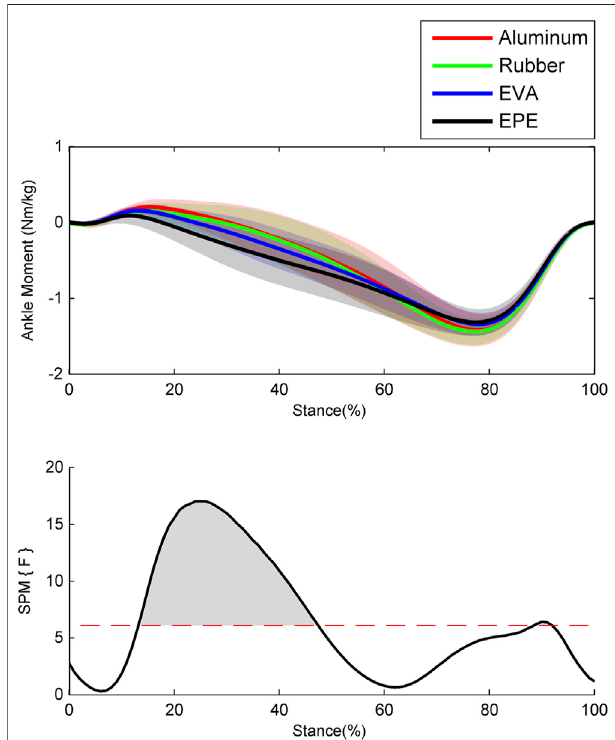
FIGURE 2 | Ensemble average curves (continuous line) and standard deviation (shaded area) for ankle moment during walking. The positive values indicate dorsi fl exion moment, and the negative values indicate plantar fl exion moment. Data are reported for the stance phase of walking with 0% beingheelstrikeand100%beingtoe-offevents.TheshadedareasintheSPM fi gure indicate that a signi fi cant difference was found ( p < 0.05) during this